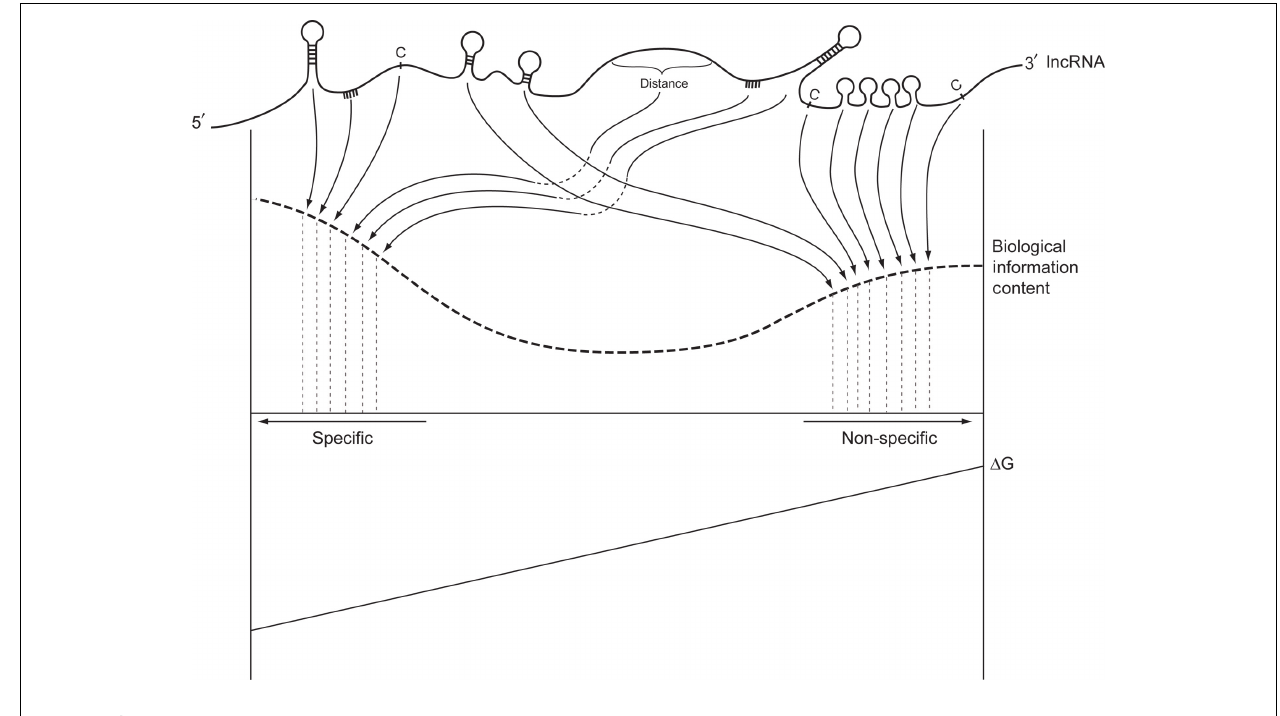
RNA can have a large number of relatively non-specific interaction sites that nevertheless have biological information content and functional significance. Their absence would result in subtle loss of signal to noise characteristics across many affected pathways that could be unrelated to the